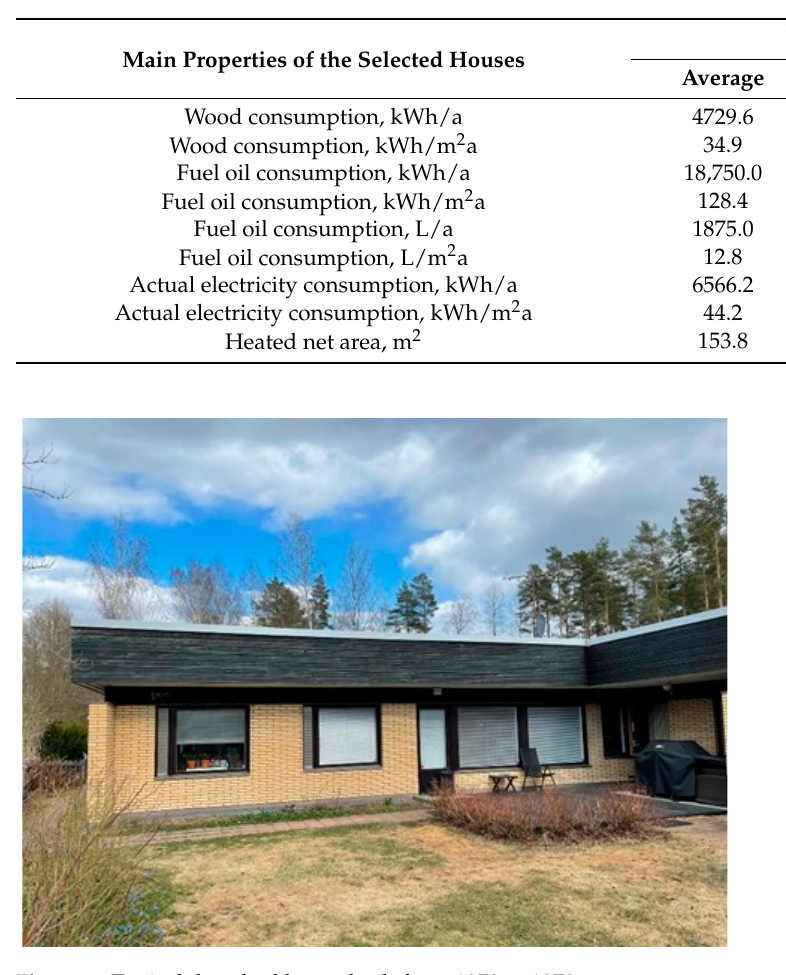
Figure 1. Typical detached house built from 1970 to 1979.